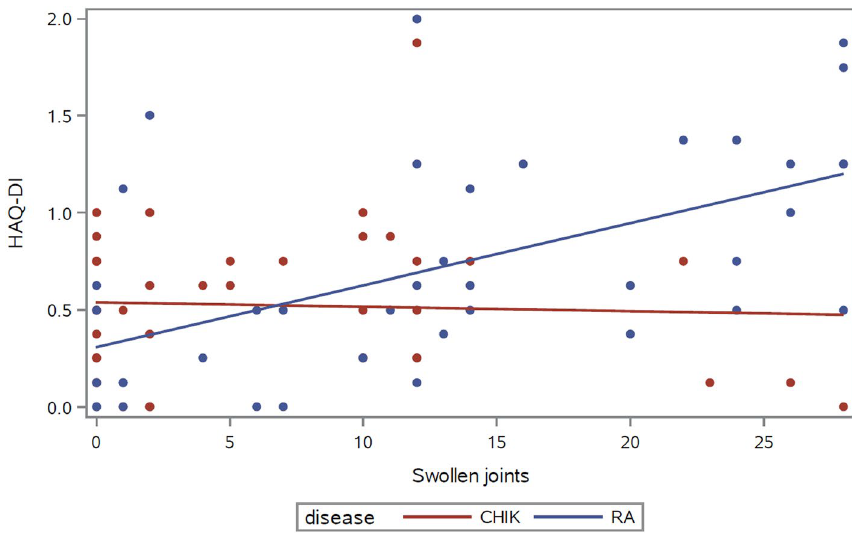
Figure 1. Relationship of swollen joint count to the HAQ-disability index in rheumatoid arthritis and in chikungunya arthritis; p = 0.003 for the interaction disease*swollen joint count.